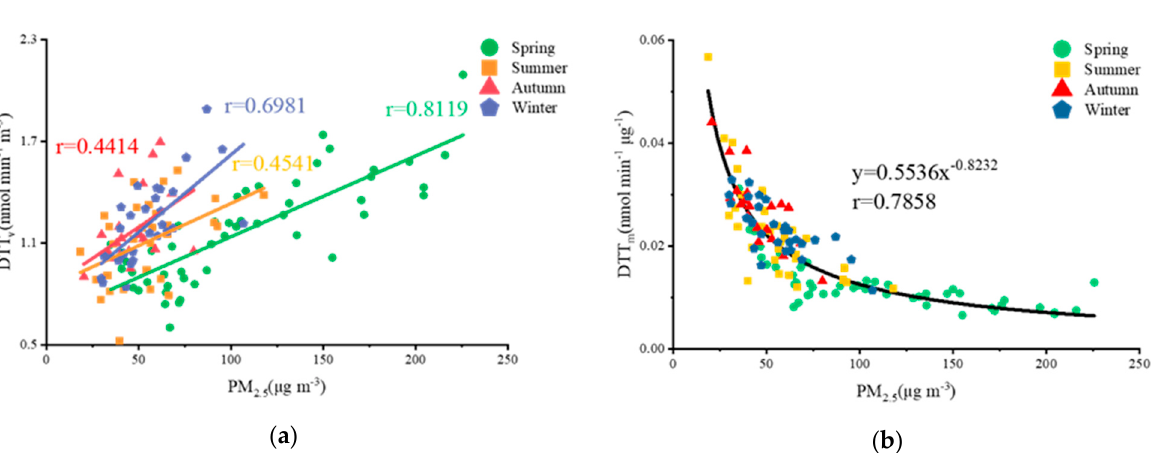
Figure 5. ( a ) Correlation between DTT v and PM 2.5 mass concentration over four seasons in Nanjing 2016; ( b ) Correlation between DTT m and PM 2.5 mass concentration over the entire year.